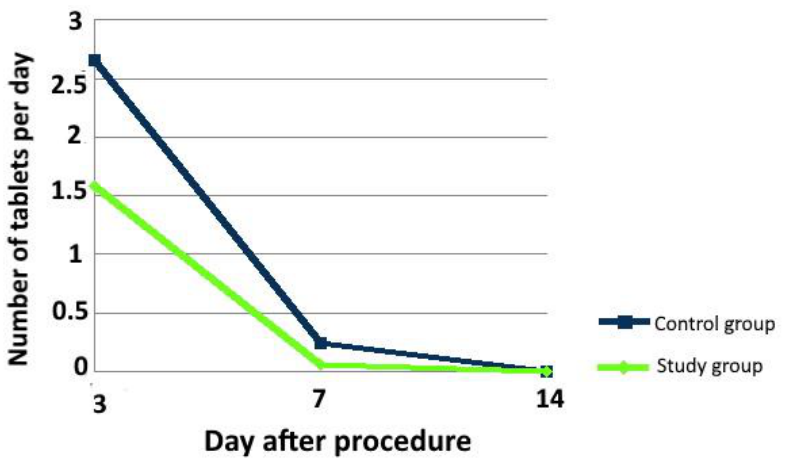
Figure 4. Time-dependent variability in the intake of painkillers in the control and study groups.